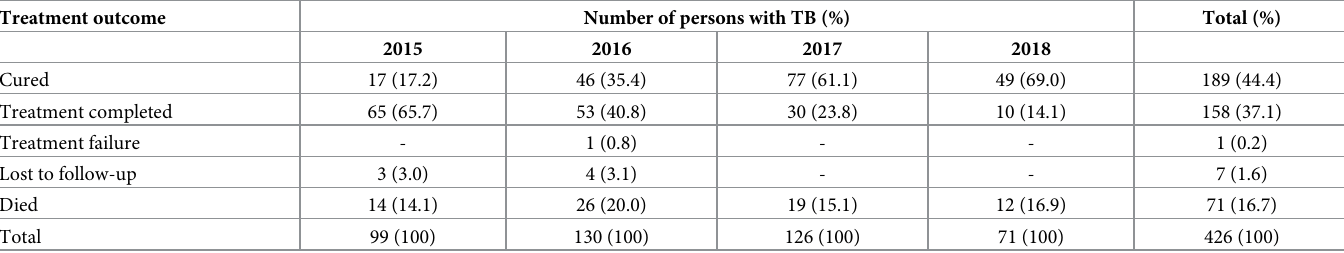
Table 3. Treatment outcomes for persons with TB in Itezhi-Tezhi District by year of treatment initiation (2015–2018). Treatment outcome